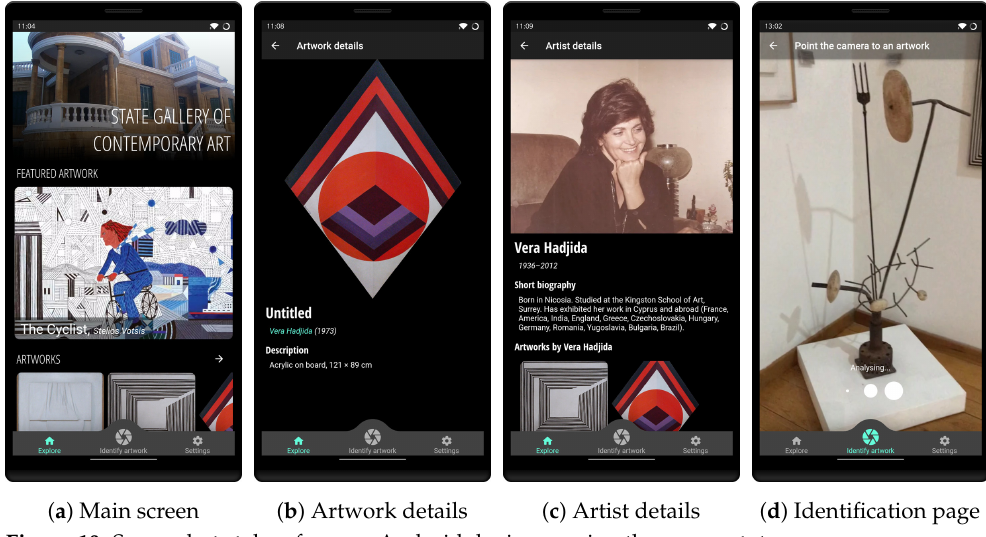
Figure 10. Screenshots taken from an Android device running the app